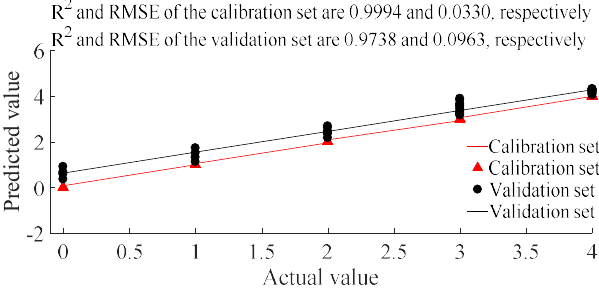
Figure 8. PLSR granulation degree detection based on SG processed spectral data.